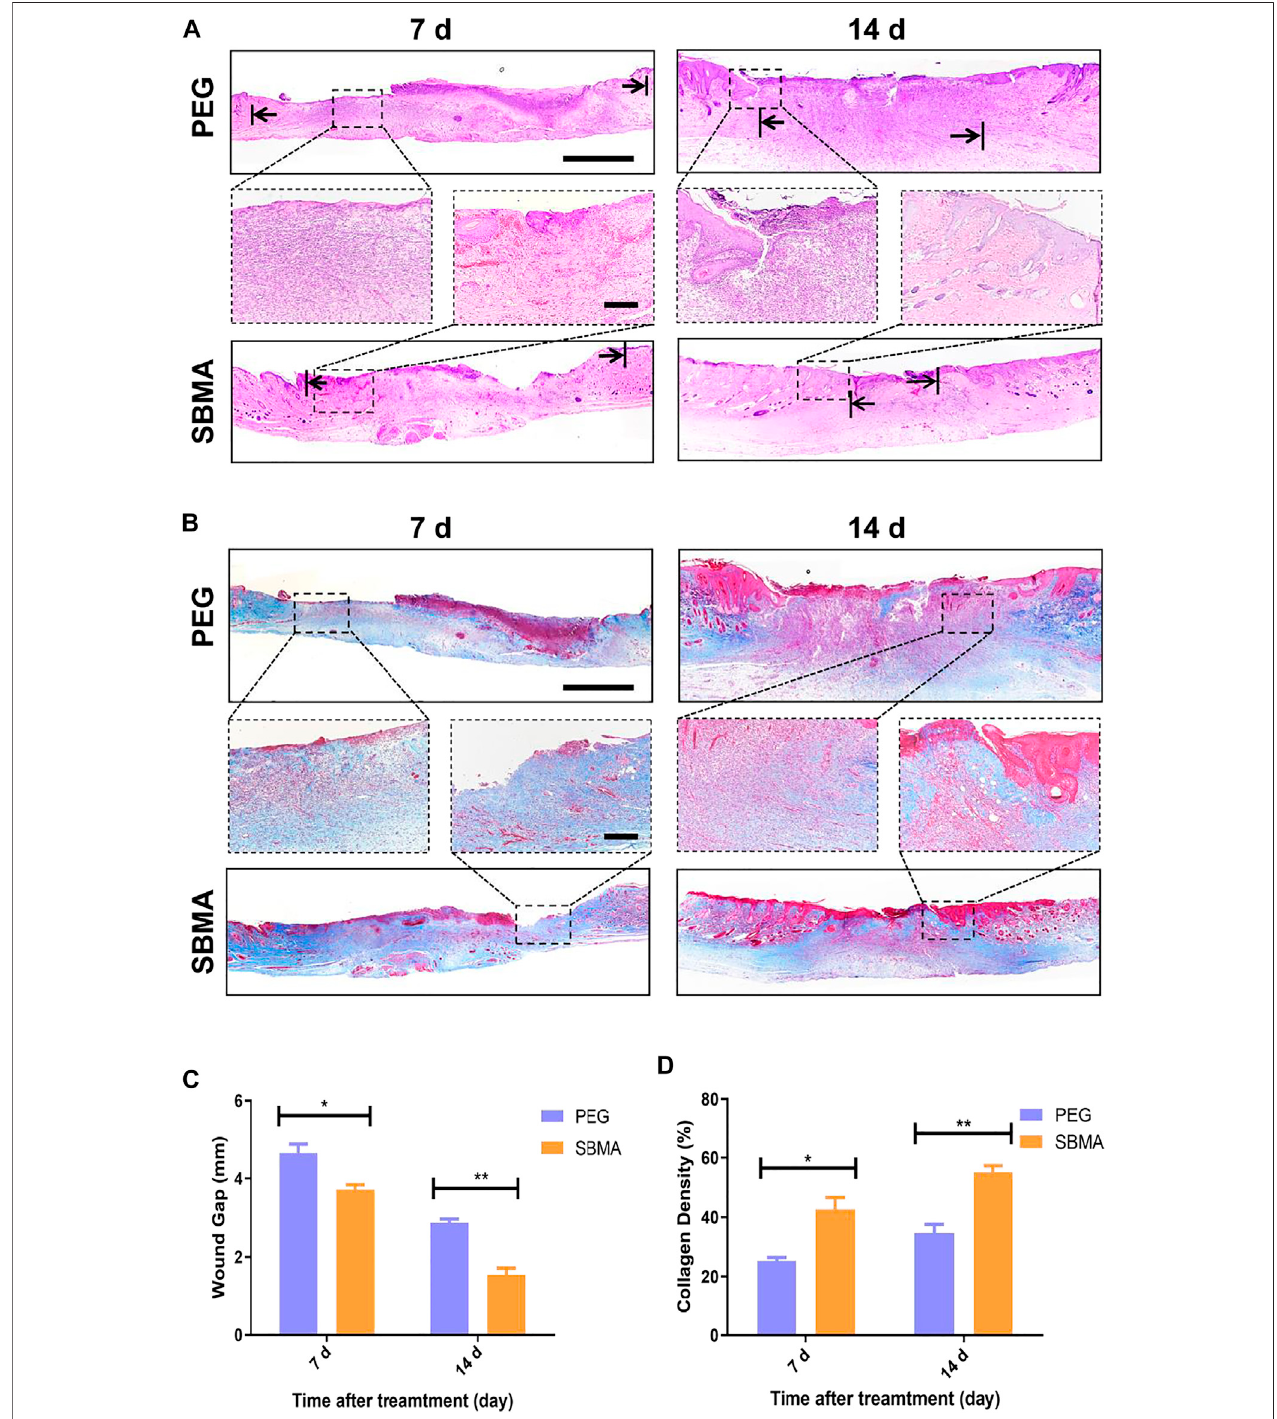
FIGURE 3 | Histological analysis of wound tissue sections on days 7 and 14 post-treatment. (A) H&E staining images of skin wounds on days 7 and 14 after the treatments of PEG or SBMA hydrogels. The black arrows indicate the edges of the healing PU wounds. The scale bars are 1 mm (left) and 200 μ m (right) . (B) Representative images of Masson ’ s Trichrome staining of the wounds on day 7 and 14 after different treatments. The scale bars are 1 mm (left) and 200 μ m (right, magni fi edimages). (C) Quanti fi edgranulationtissuegaponday7and14. (D) Quanti fi edcollagendensityonday7and14.Signi fi cantdifferenceisindicatedas* p < 0.05, ** p < 0.01, and n (cid:1) 3.